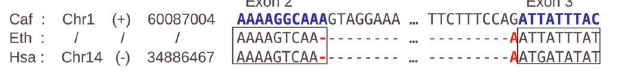
Figure 7. Inherent error generated during alignment proces- sing of Sult3a1 gene. Section of multiple alignment of the Sult3a1 gene retrieved from the output result of ancestral sequences reconstruction step. From left to right, there is the species’ name abbreviation, the chromosome’s number, the strand in parenthesis, the position and the DNA sequence. The three dots represent parts of sequence not shown here. In bold and blue, are the exons described in Caf gene, with their number written above. The fragments of sequences that will be scanned are defined from the exon inference of the Canis gene, and are highlighted by a frame. The mis-position of nucleotides is highlighted in red. As consequence there is a frame shift which will not be detected, during the sequence